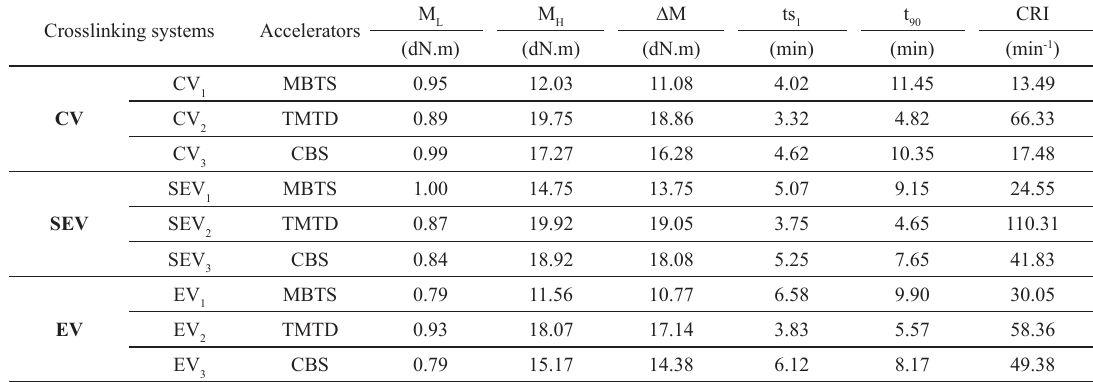
Table 2. Rheometric parameters of NR compounds vulcanized and accelerated by: MBTS, TMTD and CBS in their respective crosslinking systems. Crosslinking systems